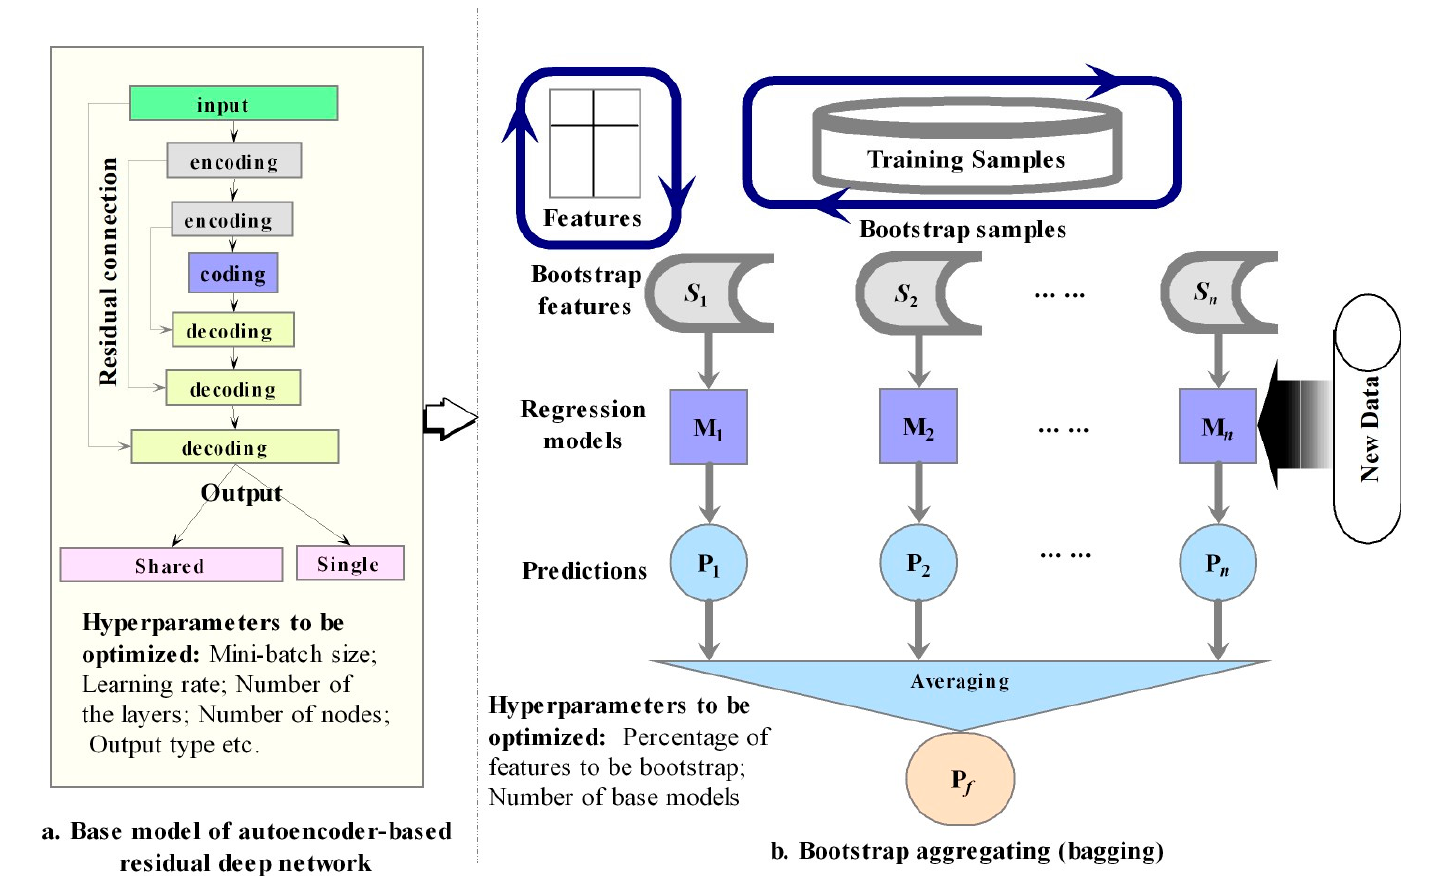
Figure 1. Modeling framework.